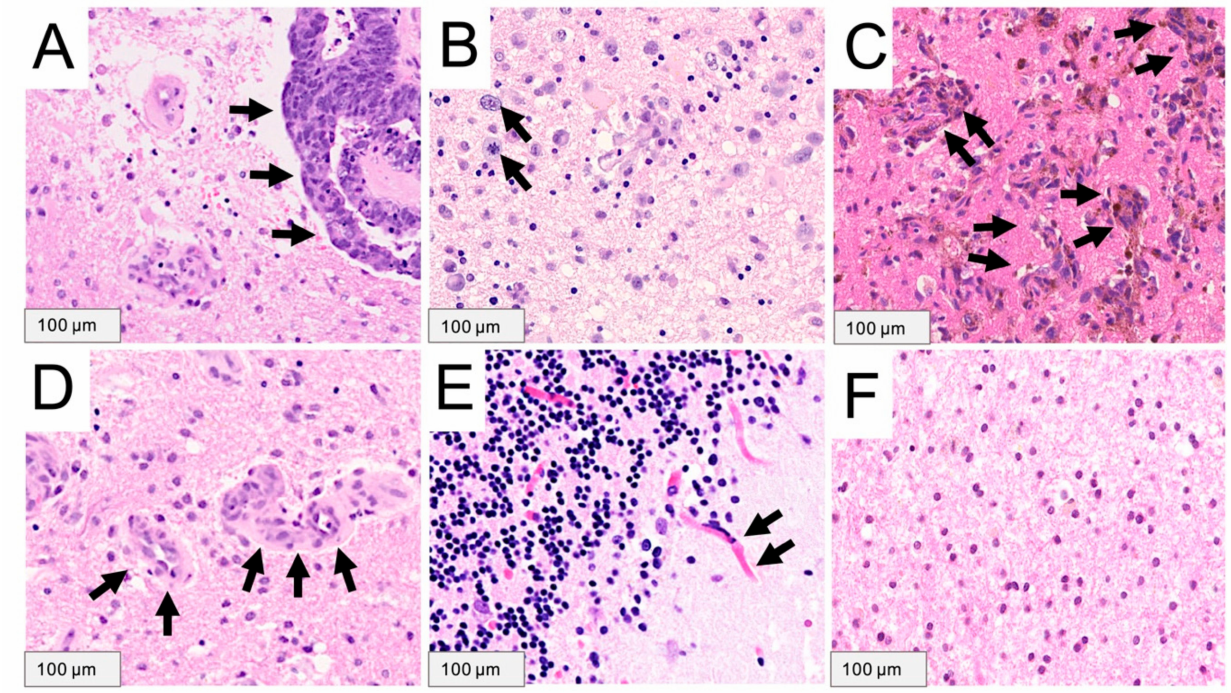
Figure 4. Histopathological examples demonstrating the different tumor cell infiltration patterns and angiogenetic features in the peritumoral brain tissue of brain metastases using hematoxylin and eosin stains under light-microscopy. ( A ) A well-demarcated growth pattern is present in a patient with a brain metastasis (black arrows) from colorectal cancer without evidence of tumor cell infiltration in the peritumoral brain tissue. ( B ) In contrast, histopathological assessment demonstrates tumor cell infiltration in the peritumoral brain tissue with either a diffuse “glioma-like” single cell infiltration (black arrows) or ( C ) growth along pre-existing blood vessels in a “vascular co-option” growth pattern (black arrows) in two patients with known melanoma. ( D ) Further, histopathological analysis shows presence of angiogenesis with a characteristic multilayered endothelium (black arrows) in the peritumoral brain tissue in a patient with colorectal cancer. ( E ) Vessels with a single endothelial layer were defined as “no angiogenesis”, ( F ) whereas angiogenesis is absent in another patient with non-small cell lung